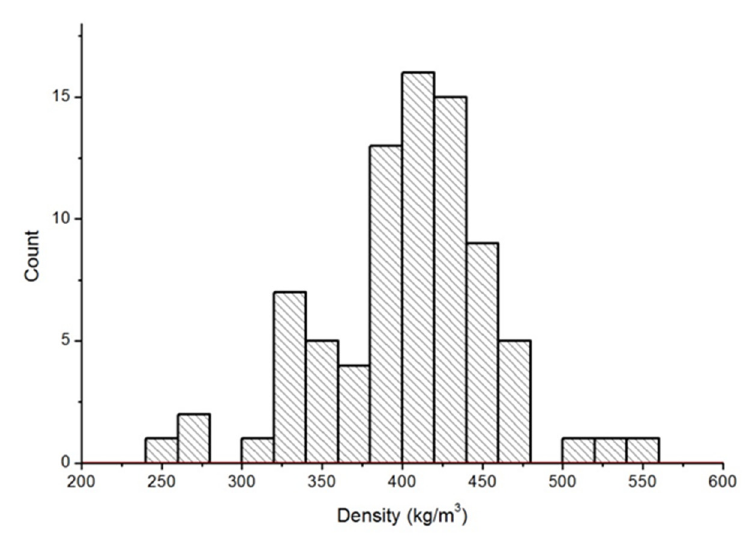
Figure 10. Ranges of snow density distributions in 2013 and 2015.